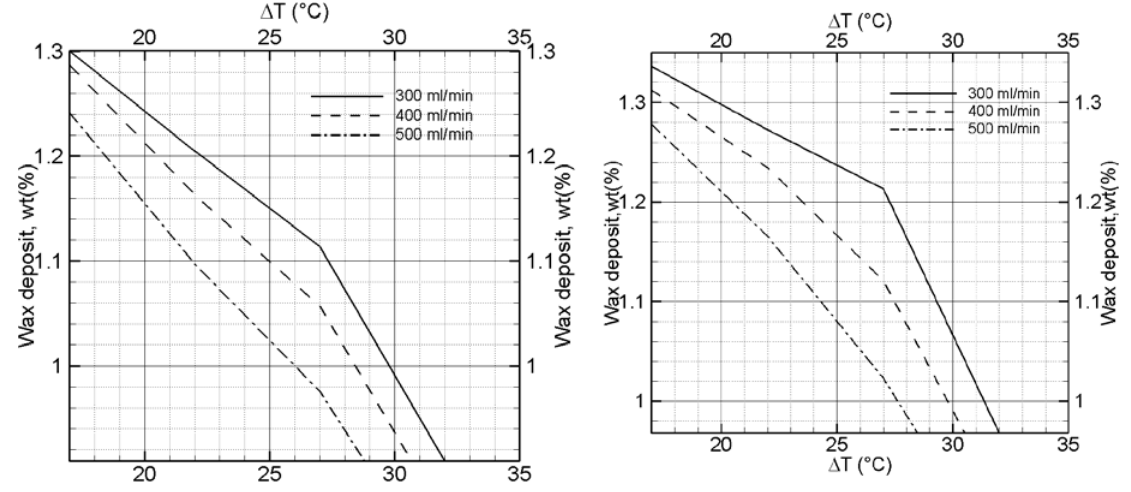
Figure 5 Effect on wax deposit (weight percentage) due to temperature differential at 60 min (Mahto and Kumar, 2013)